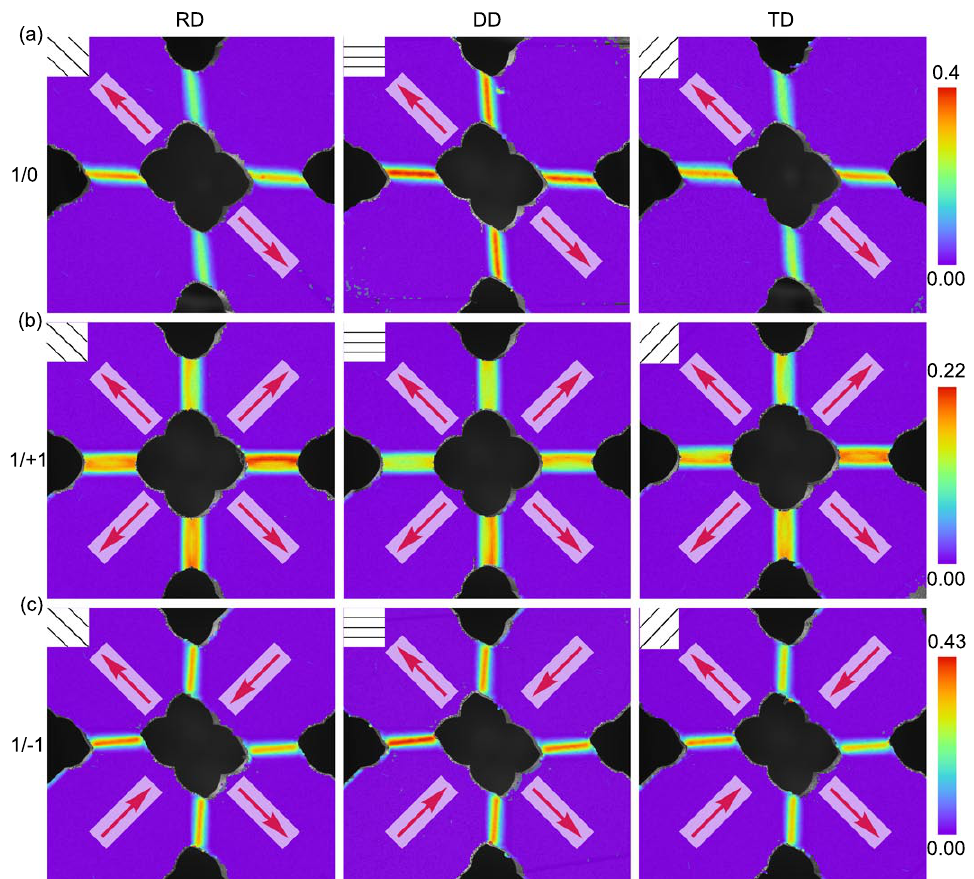
Figure 9. First principal strain fields before fracture occurs for the load ratios ( a ) F 1 / F 2 = 1/0, ( b ) F 1 / F 2 = 1/+1 and ( c ) F 1 / F 2 = 1/ −